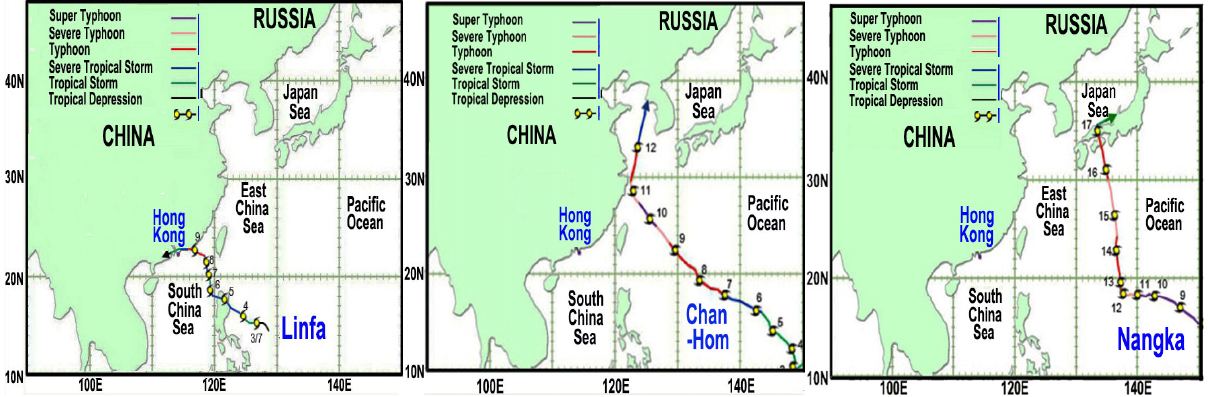
Figure 2. Typhoon tracks—STS Linfa, TY Chan-Hom, and TY Nagka (supplied by Hong Kong Observatory). Numbers (1 to 14) inside figures denote the day of July (https://www.hko.gov.hk/en/wxinfo/currwx/tc_gis.htm, assessed on 7 April 2015).